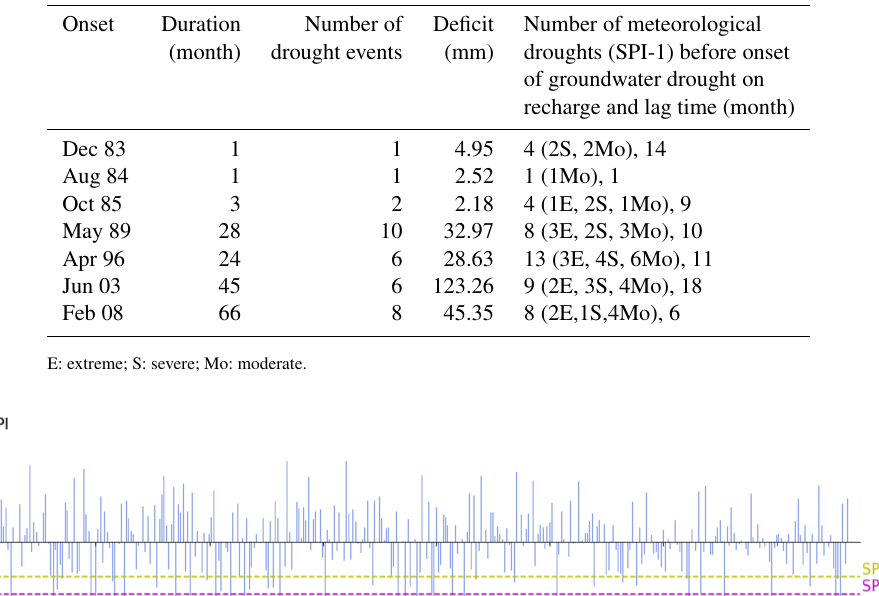
Table 3. Groundwater drought on recharge characteristics (onset, number events, duration and deficit volume) between 1981 and 2010 and number of meteorological droughts (SPI-1) ranging from moderate to extreme severity before the onset of groundwater drought on recharge with lag time.